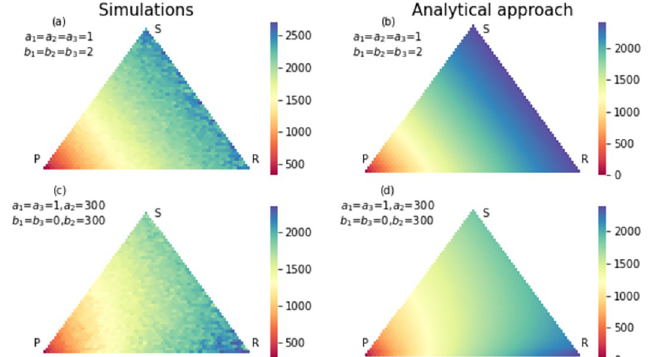
Fig 5. The simulation (a) and analytical (b) results for fixation probability of strategy paper in an RSP game with neutral selection. The size of population is 50. The states close to absorption state P = N , S = 0, R = 0 have a higher chance of absorbing in this absorption state. In (c) and (d) same results were shown with a strong selection in favor of paper strategy and detriment of rock strategy. Compared to the neutral case, many states have a higher chance to absorb to paper strategy.